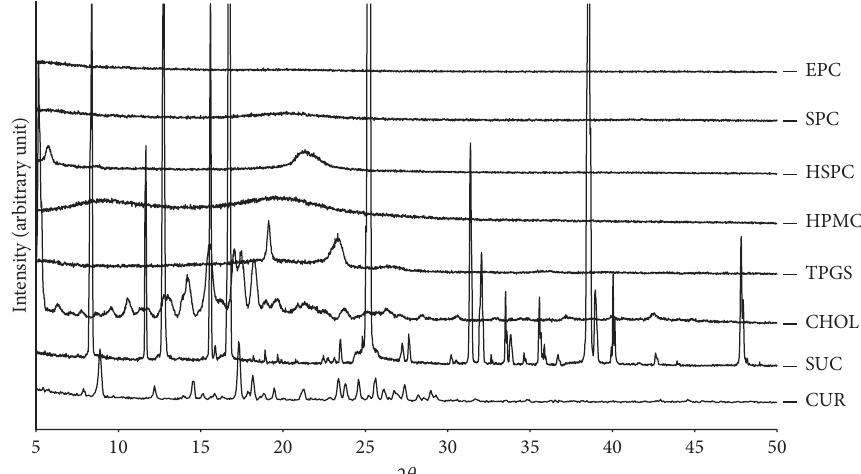
Figure 2: XRD diffractograms of all single components used in the developed CUR-loaded liposomal solid gels. Samples were scanned within a range of reflecting angle 2 θ of 5 to 50 ° at room temperature. CUR, curcumin; SUC, sucrose; CHOL, cholesterol; TPGS, D- α -tocopheryl polyethylene glycol 1000 succinate; HPMC, hydroxypropyl methylcellulose; HSPC, hydrogenated-soy phosphatidylcholine; SPC, soy phosphatidylcholine; EPC, egg